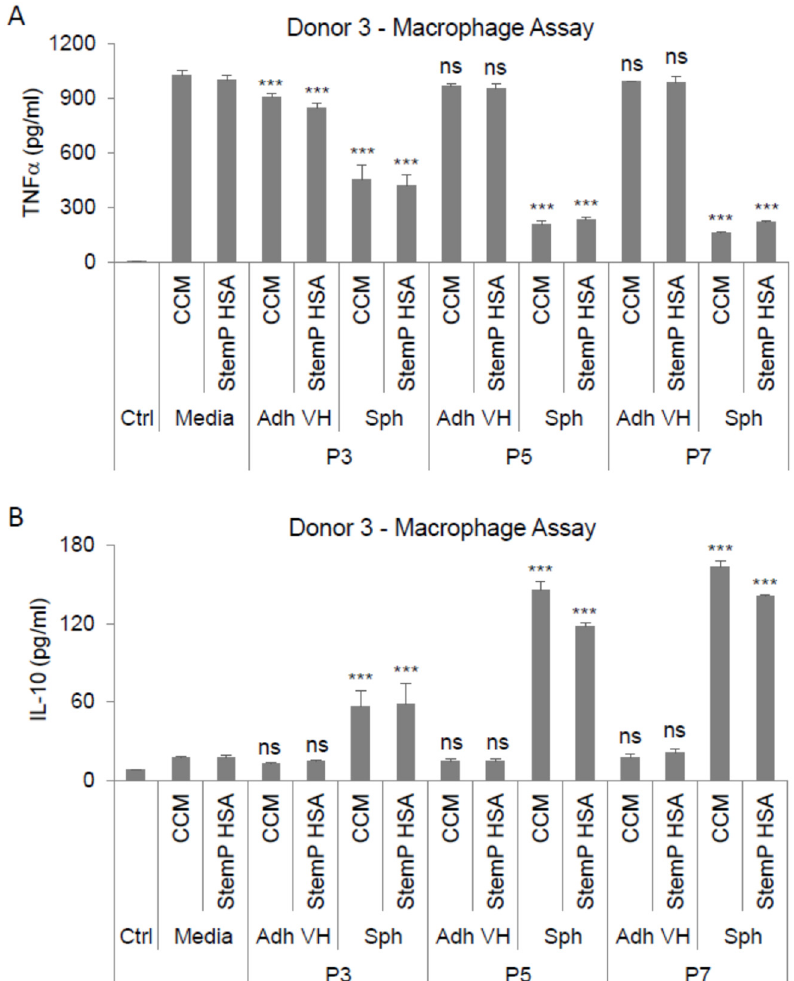
Figure 7. Spheroids generated from extensively expanded MSCs exhibit anti-inflammatory properties. MSCs from various passages (3, 5, and 7) were cultured as spheroids and as very high density monolayers in FBS-containing and xeno-free media. Conditioned media from these cultures were applied on lipopolysaccharide (LPS)-stimulated macrophages and anti-inflammatory effects were studied. ( A ) Conditioned media effects on TNF α secretion by LPS-stimulated macrophages. ( B ) Conditioned media effects on IL-10 secretion by LPS-stimulated macrophages. Compared to the appropriate media control (i.e., CCM or StemP HSA). Statistical significance was defined as ns, p ≥ 0.05; and ***, p < 0.001, Abbreviations: Adh VH, adherent very high density monolayer MSCs; CCM, complete culture medium; Ctrl, control unstimulated macrophages; P3, passage 3; Sph, spheroid MSCs; StemP HSA, StemPro xeno-free media with human serum albumin.